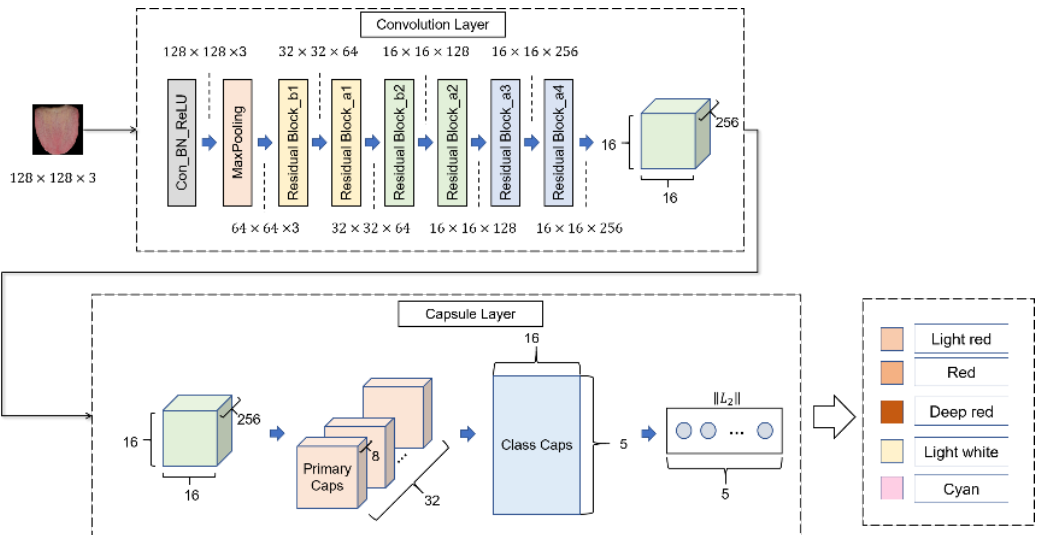
Figure 5. This is the framework of TongueCaps. It is composed of two parts, the convolution layer and the capsule layer, which input an image through these two parts and finally, output the proba- bility that the input image belongs to five kinds of tongue colors.